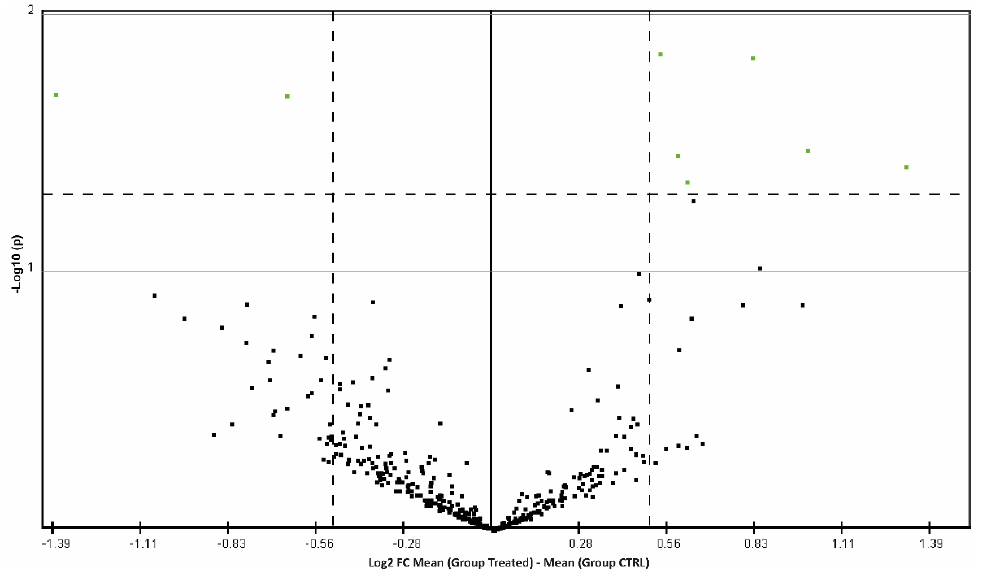
Figure 1. Nanostring miRNA profiling analysis. Volcano plot displaying the differences in fold change (log2FC) of miRNA expression in resveratrol treated FF samples vs. CTRL obtained after data normalization analysis. The x -axis indicates differences in log2FC and the y -axis indicates the -log10 p -value. The horizontal dashed line indicates the threshold for probability of significance ( p = 0.05) and the vertical dashed lines set the threshold to 0.5 for the difference in FC of miRNA expression. miRNAs whose expression level is at least 0.5-fold different in resveratrol treated FF samples compared to CTRL, with p < 0.05 corrected for multiple testing by using the Bonferroni method, are indicated by green